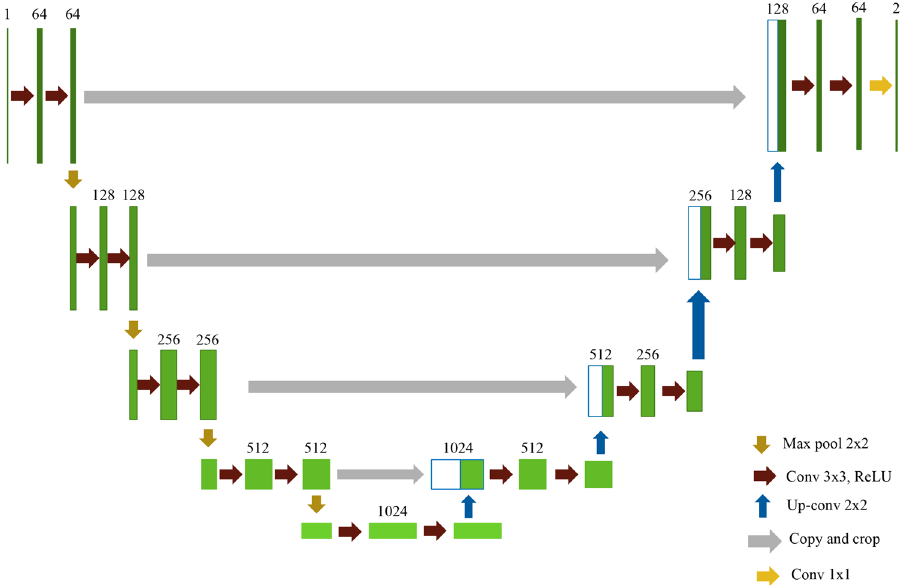
Figure 3. The structure of the U-Net model 39